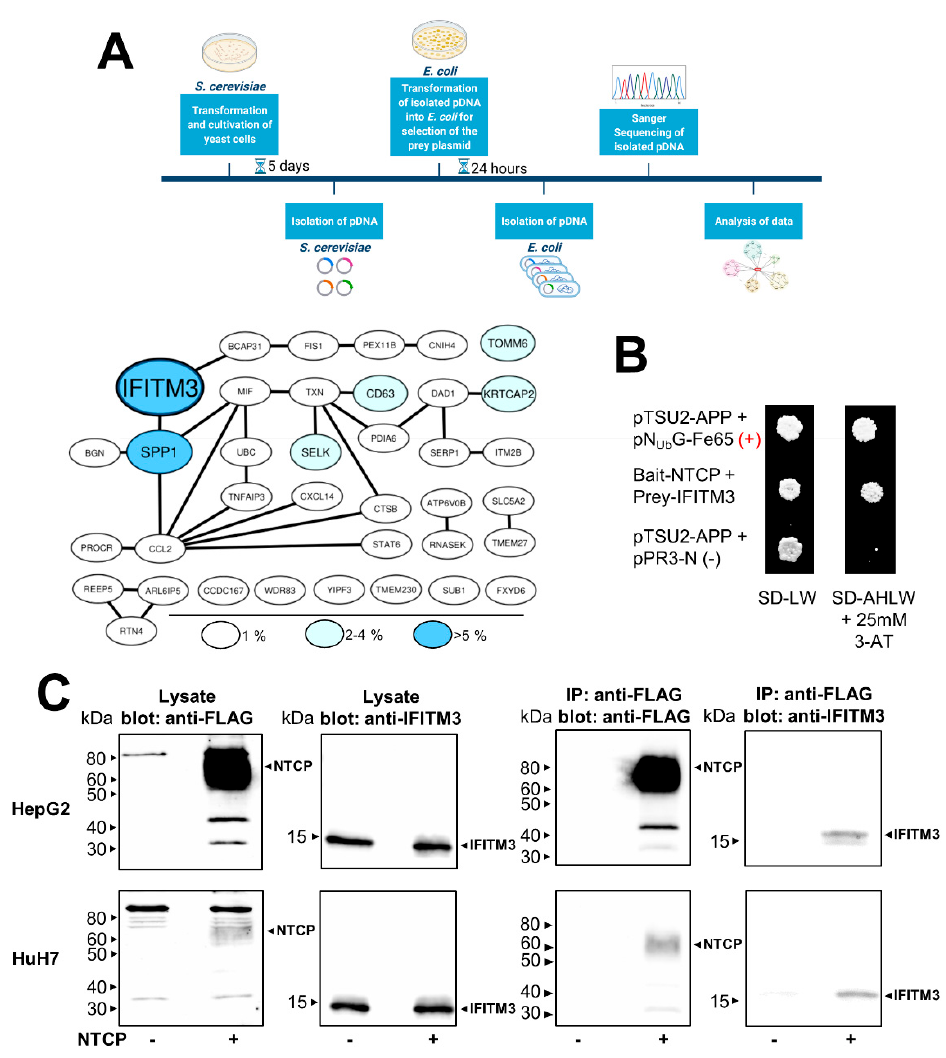
Figure 1. Protein–protein interaction between NTCP and IFITM3. ( A ) Yeast cells were co-transformed with the NTCP-C Ub -LexA-VP16 bait construct and the N Ub -human kidney cDNA prey library. The pDNA of 200 yeast cells grown on SD-AHLW plates was selected for the interacting prey construct by transformation of the pDNA in E. coli and incubation on plates containing ampicillin. The isolated prey pDNAs were sequenced, and the corresponding proteins were analyzed and illustrated in an interaction map. Color and size of the protein labels indicate the frequency among the 200 hits analyzed. IFITM3 was the most common hit with an 11/200 hit rate. ( A ) was created with BioRender (biorender.com). ( B ) The ORF of IFITM3 was sub-cloned into the pPR3-N prey vector and co-transformed with the NTCP-C Ub -LexA-VP16 bait construct into yeast cells. In addition, the control construct pTSU2-APP was co-transformed with either the pN Ub G-Fe65 prey construct (positive control) or the pPR3-N empty vector (negative control). NTCP-C Ub -LexA-VP16 expression from the bait construct was previously described [31]. Colony growth was analyzed on SD-LW plates (lacking leucine and tryptophan) and on SD-AHLW plates (additionally lacking adenine and histidine). ( C ) HepG2-NTCP and HuH7-NTCP cells were seeded on 6-well plates; non-NTCP- expressing HepG2-TetOn and HuH7-FlpIn cells served as negative controls. Cells were lysed after 48 h, and the lysates were used for IP with anti-FLAG agarose. The lysate and IP samples were processed for Western blotting with an anti-FLAG antibody or an anti-IFITM3